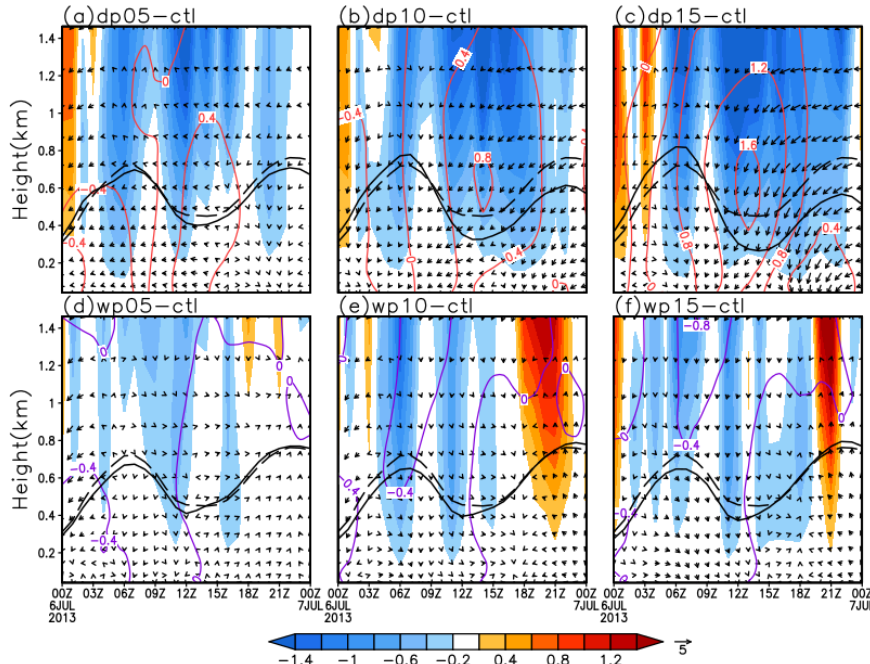
Figure 13. Time versus height vertical coordinate cross-sections of area-averaged vertical wind velocity (shaded; units: cm∙s −1 ), horizontal winds (vectors; units: m∙s −1 ) for the sensitivity minus the CTL experiments, and PBL top of sensitivity experiments (dashed thick black line) and the CTL experiment (solid thick black line) on 6 July. The perturbed potential temperature differences between DP ensembles and CTL experiment are plotted in red lines and contoured in 0.4 (units: K), the water vapor mix differences between WP ensembles and CTL experiment are plotted in blue lines and contoured in 0.4 (units: g∙kg −1 ). ( a ) dp05 – CTL, ( b ) dp10 – CTL, ( c ) dp15 – CTL, ( d ) wp05 – CTL, ( e ) wp10 – CTL, ( f ) wp15 – CTL.